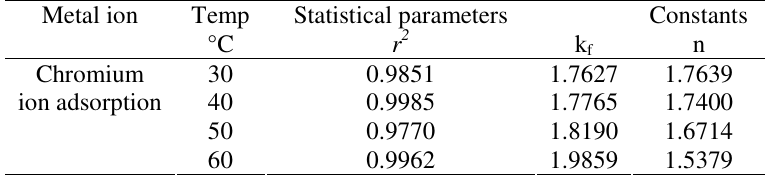
Table 3. Freundlich isotherm results.